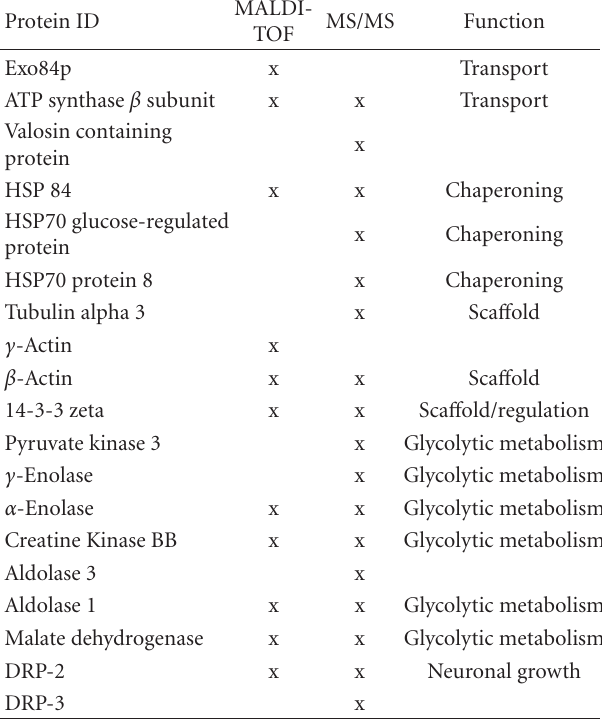
Table 1: Proteins interacting with MT-3 identified with MALDI- TOF and MS/MS, and their